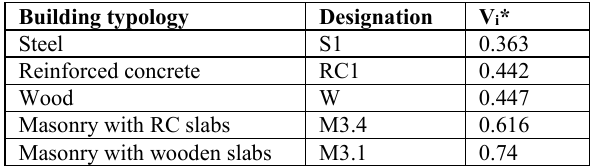
Table 3 . Building typology classes. Source: de Vries, 2022